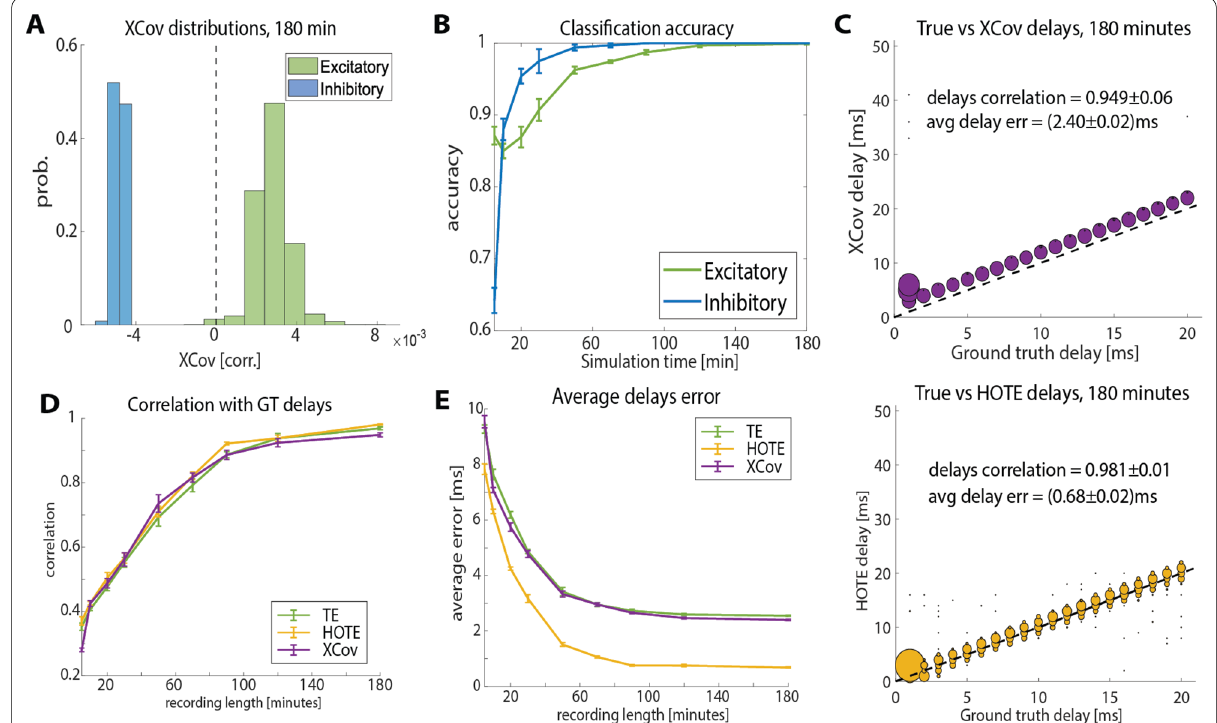
Fig. 4 Performance of the measures in estimating connection type and delays. A Distributions of static FC values measured using XCov for excitatory (green) and inhibitory (blue) cells. B Performance of a classifier in identifying excitatory and inhibitory synapses with simulation length. The decision boundary of the classifier was set to XCov 0. C Scatter plots of real and estimated delays across cell pairs using XCov (top) and HOTE = (bottom). The size of the markers is proportional to the number of pairs having that specific combination of ground truth and estimated delay. The dashed line is the identity line x y . Black dots far from the identity line correspond to pairs of inferred and ground truth delays that occurred only = once. D Correlation between ground truth and estimated delays with simulation length. E Average error in delay estimation with simulation length. All error bars in the figure are SEM across repetitions of the simulation ( N =